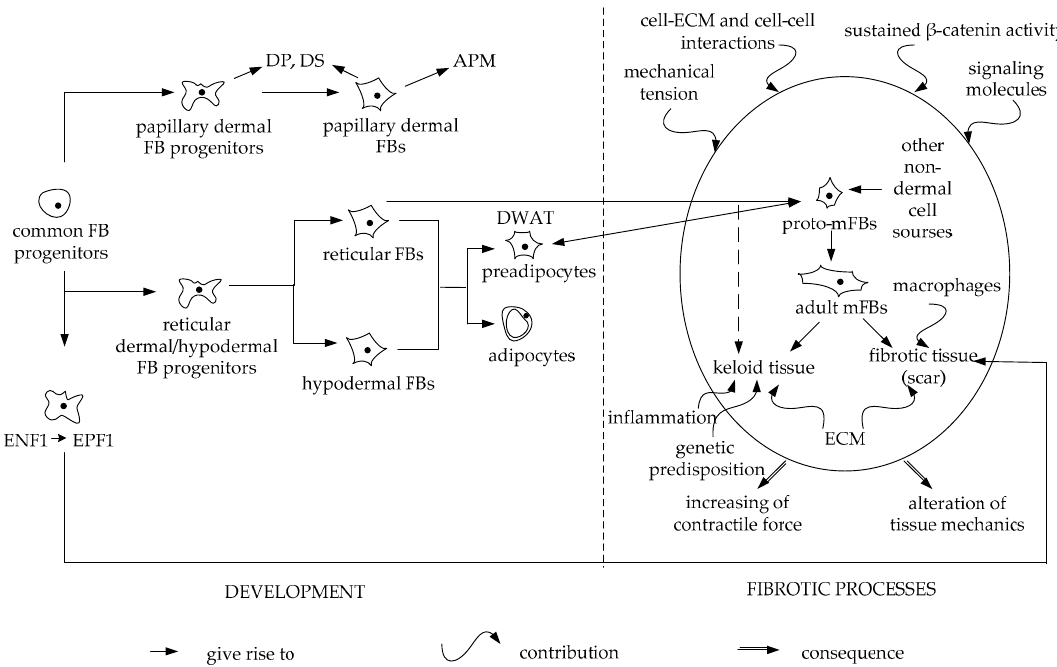
Scheme 1. Origin of dermal cell types and their participation in fibrosis. The left part of the scheme is a schematic representation of dermal cells development and their heterogeneity, using data from Driskell with co-authors [14] with the addition of data from Jiang with co-authors [95] on the participation of ENF1 and EPF1 cells in the scar formation. The right part of the scheme summarizes data on the relationship of cellular and other factors on scar formation. APM—arrector pili muscle;